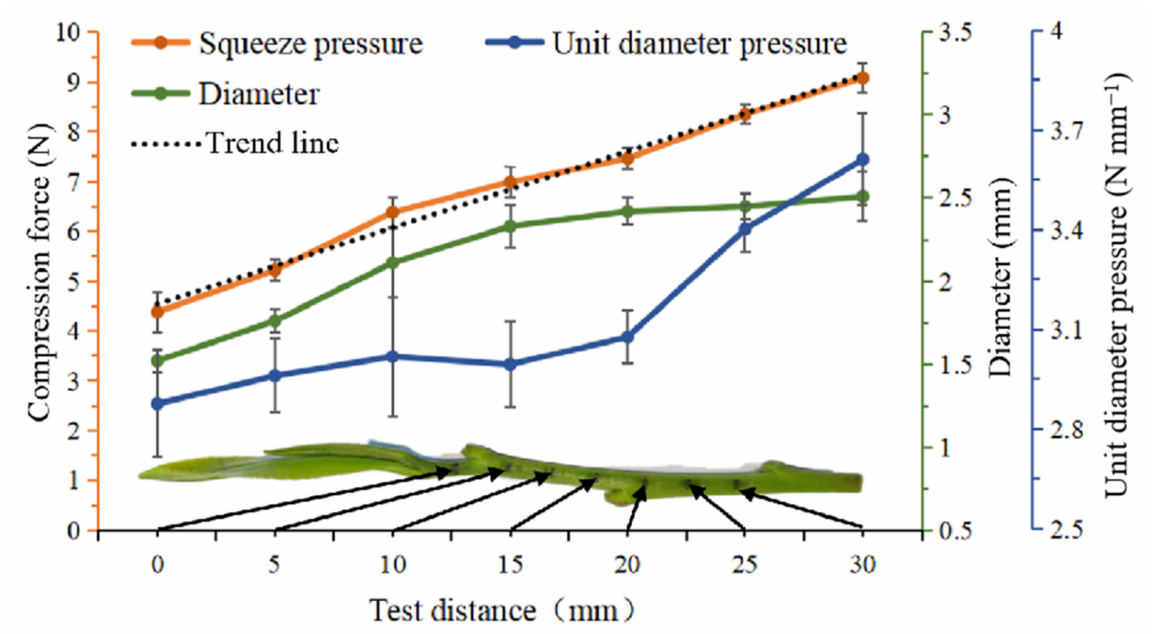
Figure 8. Maximum force on different points on the measured tea